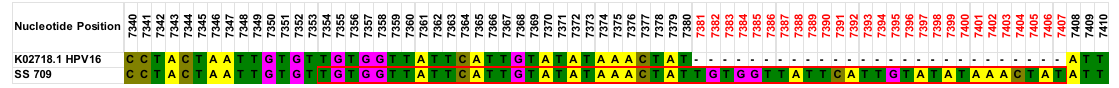
Figure 3. Alignment of partial SS 709 LCR sequence (7340–7410 nt) with K02718 HPV16 reference sequence. The 27 nt duplication detected is highlighted in red.